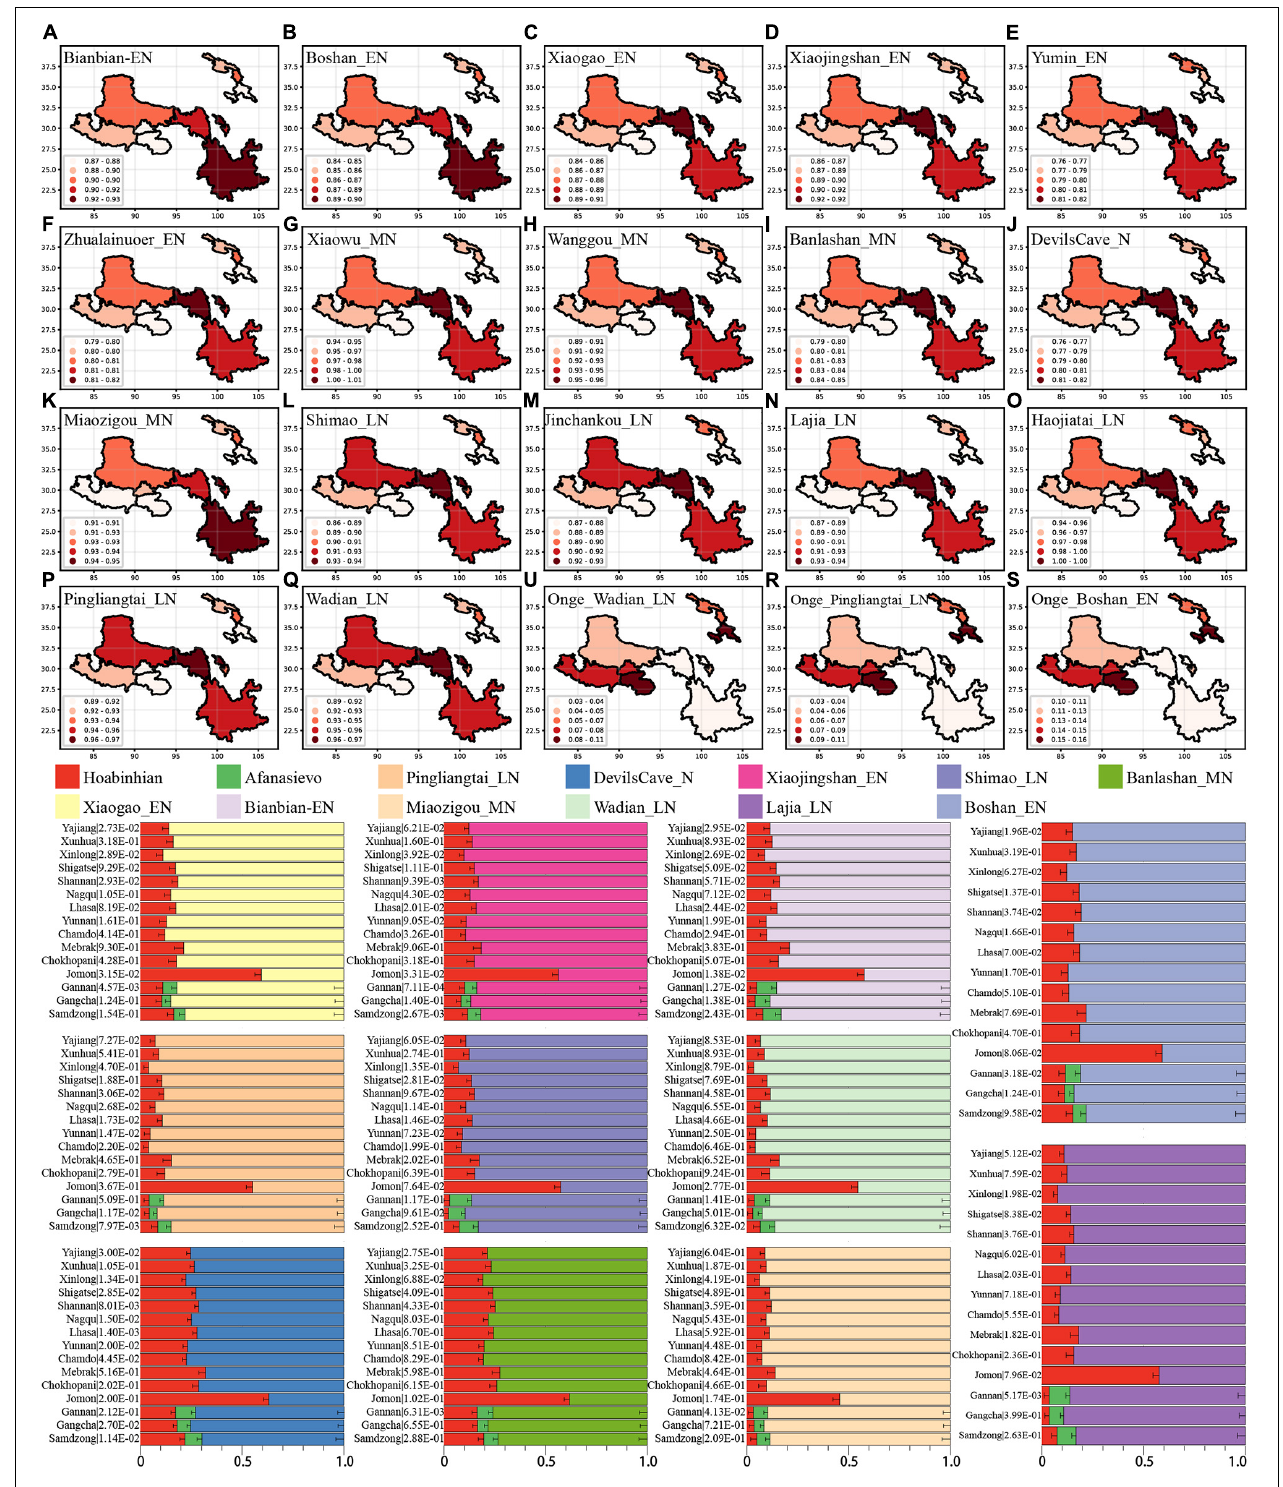
FIGURE 5 | Results of qpAdm showed the main ancestry composition of ancient/modern Tibetans and Jomon Hunter-Gatherer were the results of the mixing of ancient NEA and one deep lineage associated with South Asian Hunter-Gatherer Onge or Southeast Hunter-Gatherer Hoabinhian (the early Asian). Heatmap showed the NEA-related ancestry in the two-way admixture model of Onge and the early Neolithic East Asian (A–F) , Middle-Neolithic NEA (G–K) , and Late-Neolithic NEA (L–Q) . Onge-related ancestry was presented with three cases (R,S,U) . Bar plots showed the ancestry composition of the two-way model of Hoabinhian and East Asian for modern Tibetan, Jomon and Ancient Nepal Mebrak and Samdzong people, and three-way model for Qinghai and Gansu Tibetans.